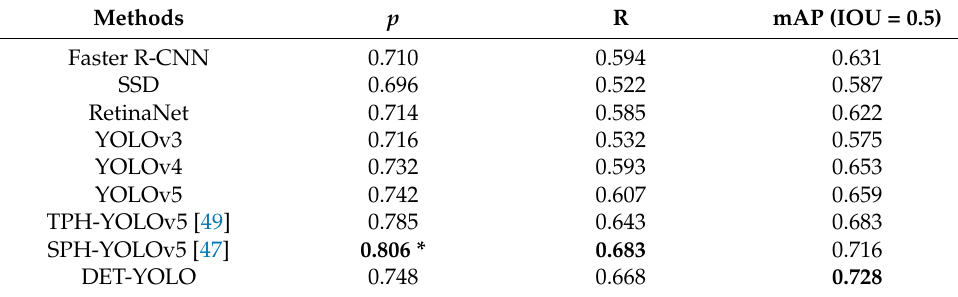
Table 3. Comparison of the performances on the DOTA dataset.